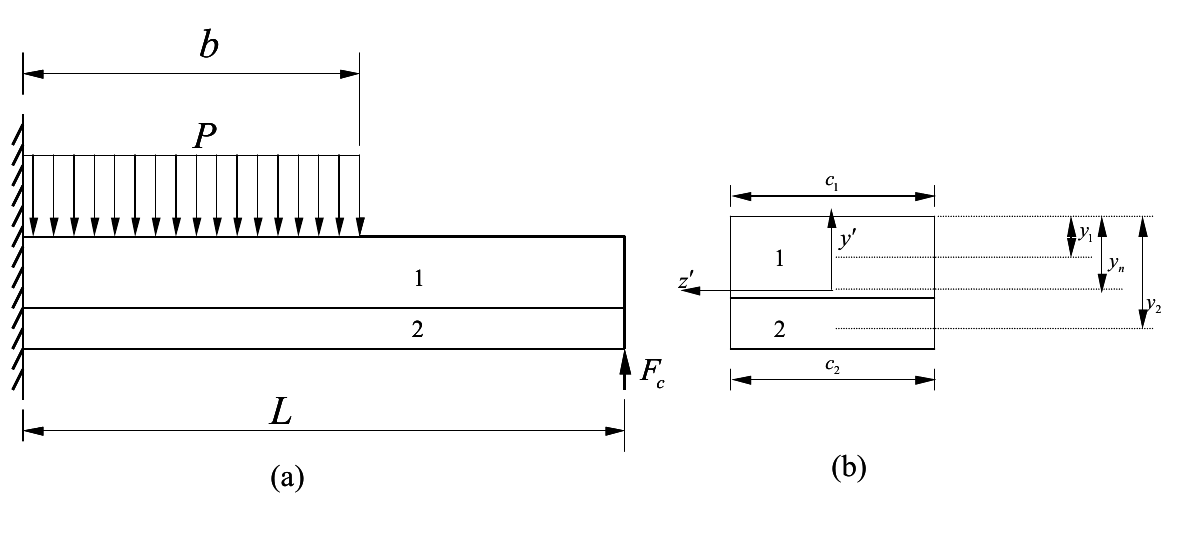
Figure 2. Schematic illustration of the contact load and the cross section of the microrelay